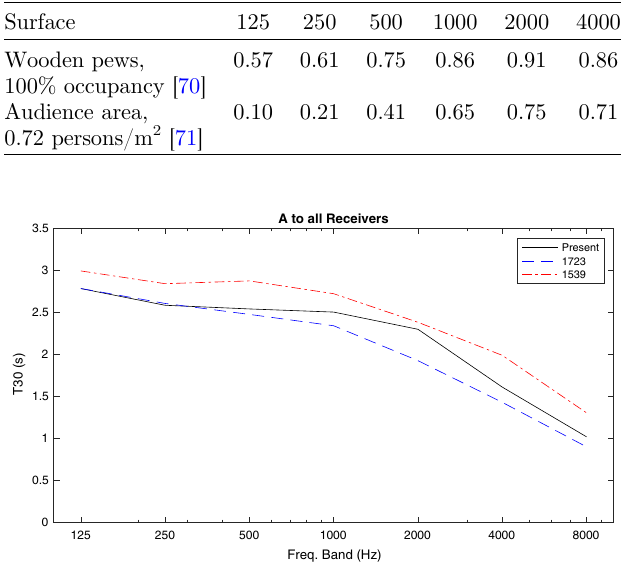
Figure 10. Simulated T30 for fully occupied Thomaskirche in all three eras, from source A, spatially